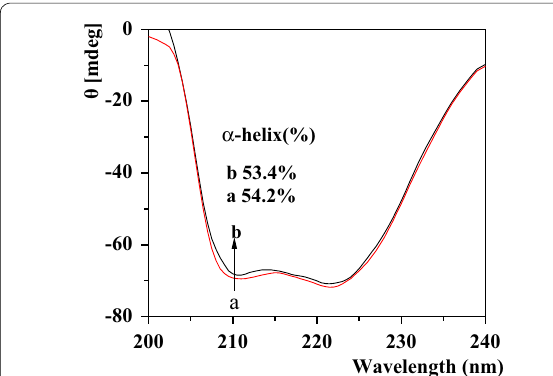
Fig. 10 CD spectra of HSA in the absence (a) and pres‑ ence of (b) paeoniflorin ([HSA] florin] 2.5 10 − 5 mol L − 1 ) = ×